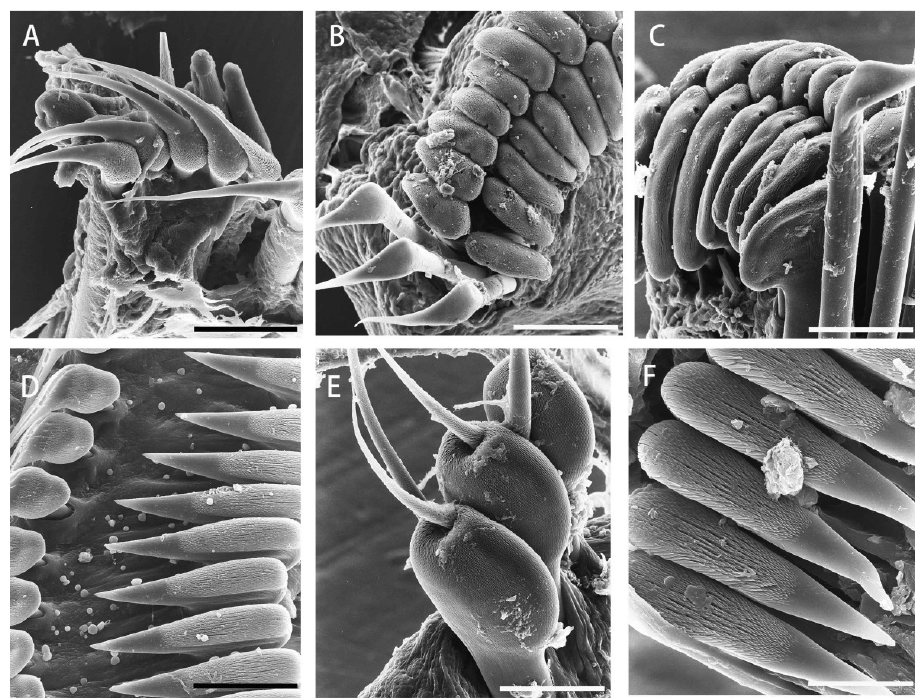
Figure 3. Notaulax yamasui sp. n. SEM micrographs of chaetae and uncini. A collar chaetae B 3 rd left notopodial thoracic fascicle C detail of B, showing superior chaetae D uncini and companion chaetae, 3 rd thoracic neuropodial torus E inferior abdominal spatulate chaetae showing distal mucros from 7 th fascicle of abdomen, lateral view F abdominal uncini. Scale bars 30µm ( A ), 60µm ( B ), 40µm ( C ), 30µm ( D, E ), 12µm ( F